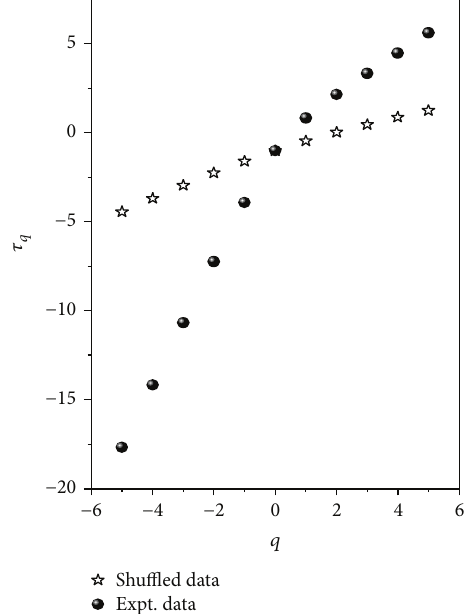
Figure 3: Plot of 𝜏(𝑞) versus 𝑞 for different interactions.